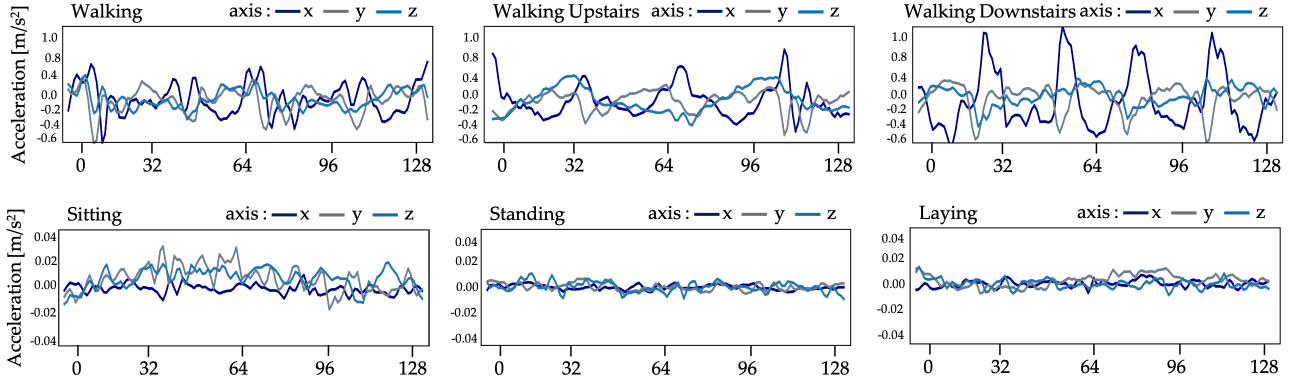
Figure 5. Accelerometer data from UCI-HAR dataset.